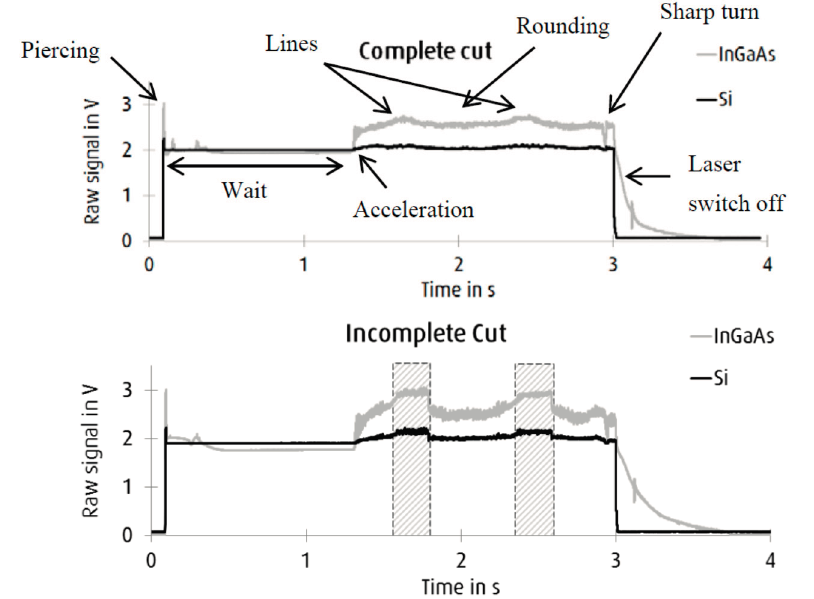
Figure 4. Voltage signal delivered by the Si and InGaAs diodes of a complete ( top ) and incomplete ( bottom ) cut. The time of the cutting interruption is marked by dashed